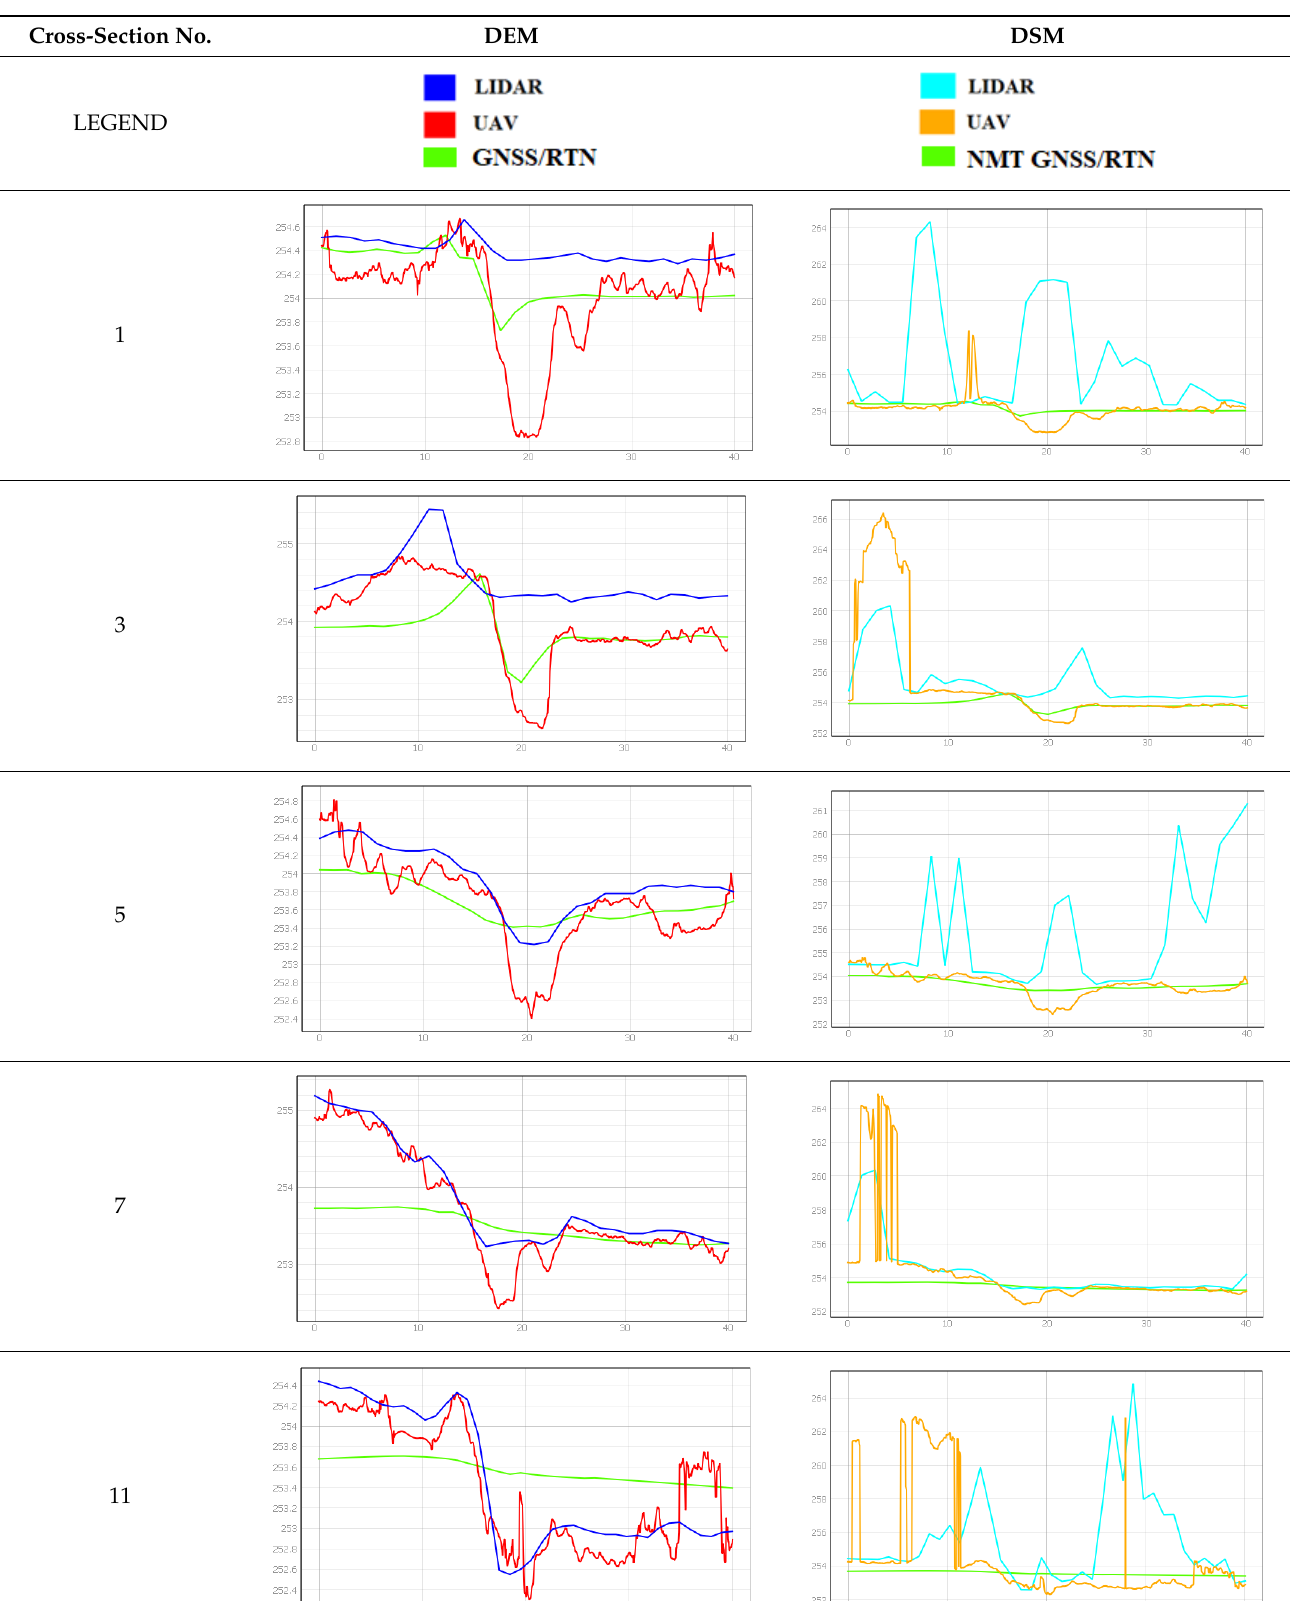
Table 4. Cross-sections of the watercourse bed on the DEM and DSM in raster form; source: own elaboration. Cross-Section No.